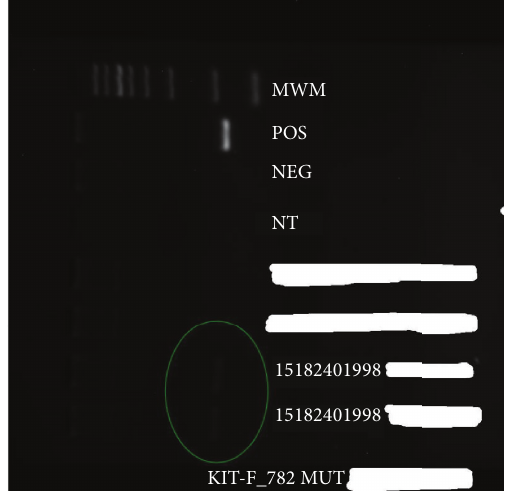
Figure 3: Sequence analysis of the KIT D816V mutation.